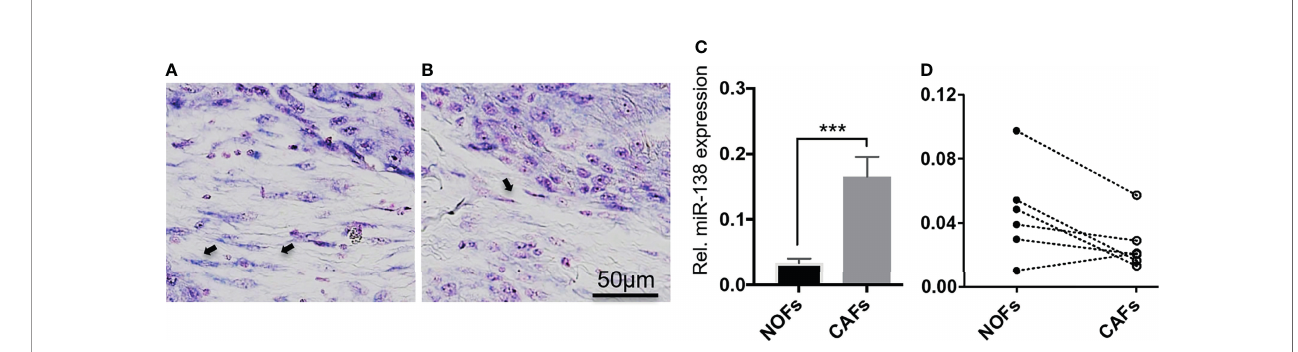
FIGURE 2 | Heterogenous expression of miR-138 in cultured fi broblasts from OSCC lesions and normal mucosa. (A, B) Differential miR-138 expression in CAFs from different regions of tumor center. Fibroblasts are marked with arrows. (C) miR-138 expression in non-matched CAFs and NOFs. (D) miR-138 expression in matched NOFs and CAFs. Each pair is connected by dotted lines. *** p <